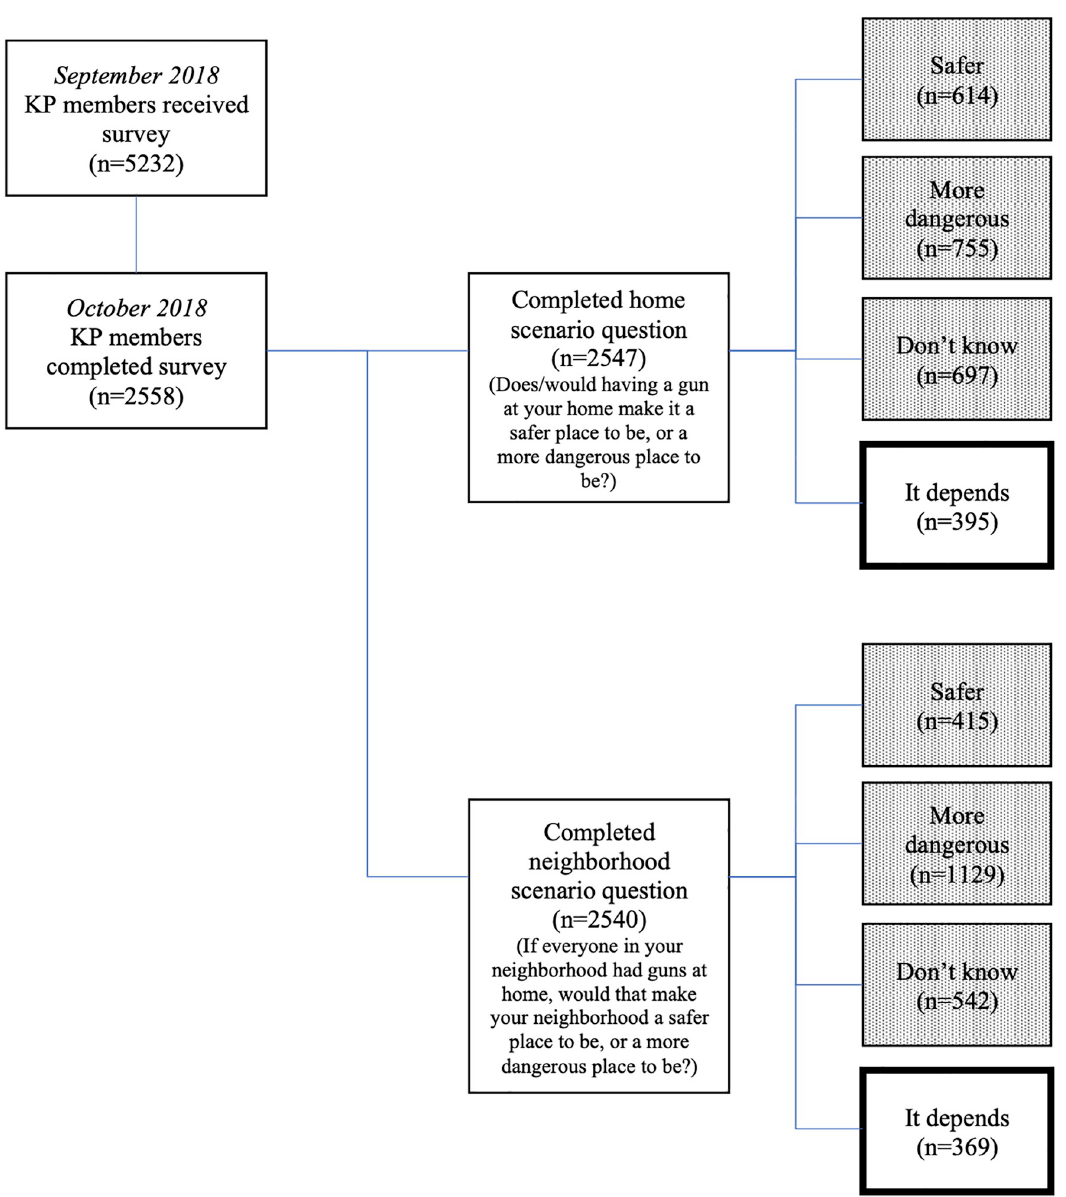
Fig 1. Recruitment and participation of sample. Note: Counts are unweighted. Dotted boxes denote groups that are not shown in these analyses. Groups detailed in thick outlined boxes are included in these